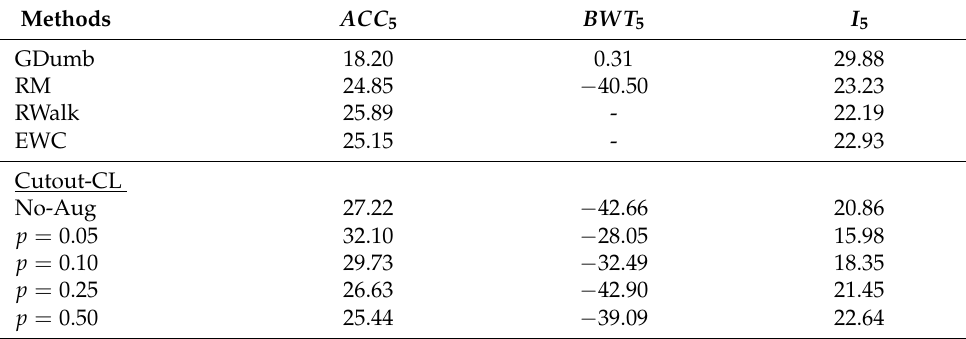
Table 2. Spectrogram-DAS CL accuracy.